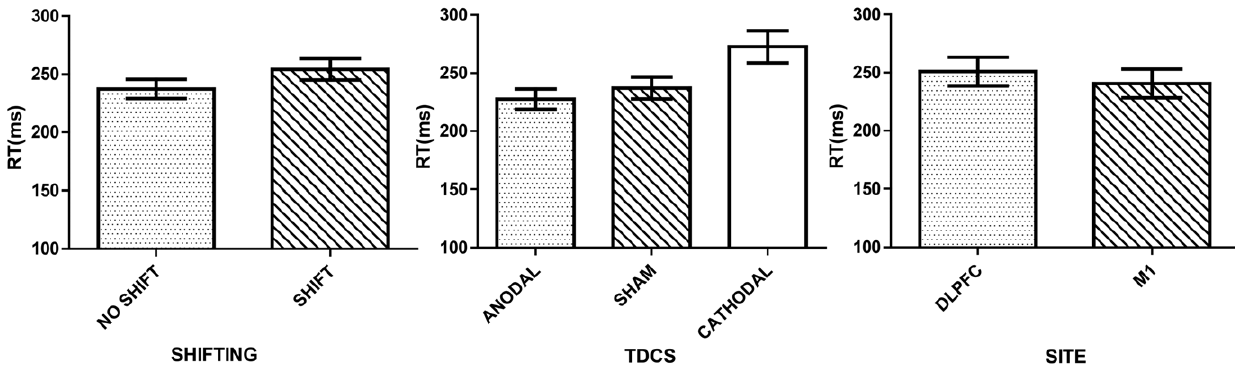
Figure 3. Performance as indexed by RT in the Motor Task. Columns represent the MEAN and the bars the SEM (95% CI) for the RT in the Motor Task. Shifting: No shift represents the RT when the motor sequence remained the same (e.g., AA or BB), while Shift represents the RT when there were changes in the motor sequence set (e.g., AB or BA). tDCS: Represents the effects of polarity on performance. Site: Represents the estimates of the RT per site.